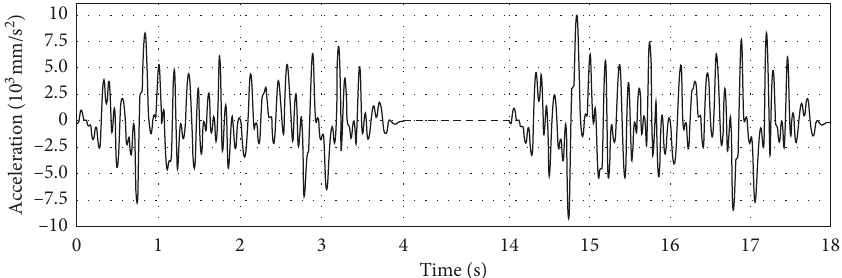
Figure 7: An artificial ground motion